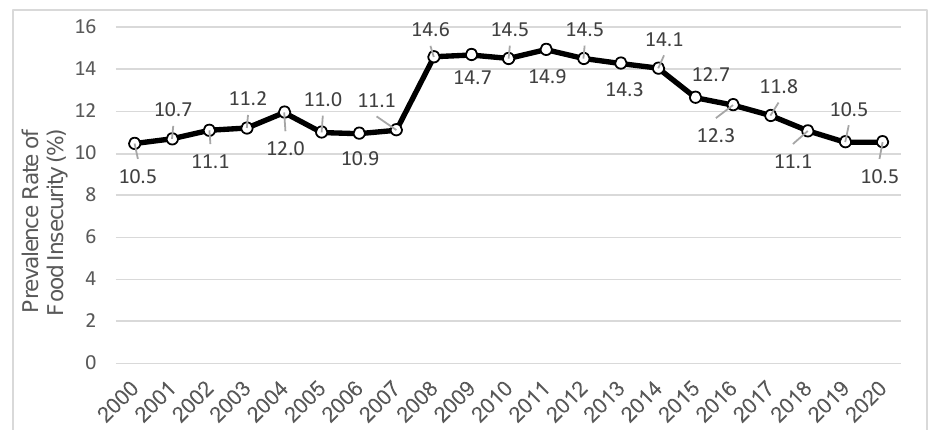
Figure 1. Trends in the prevalence rate of food insecurity (includes low and very low food insecurity) in U.S. Households — source: U.S. Department of Agriculture (USDA).